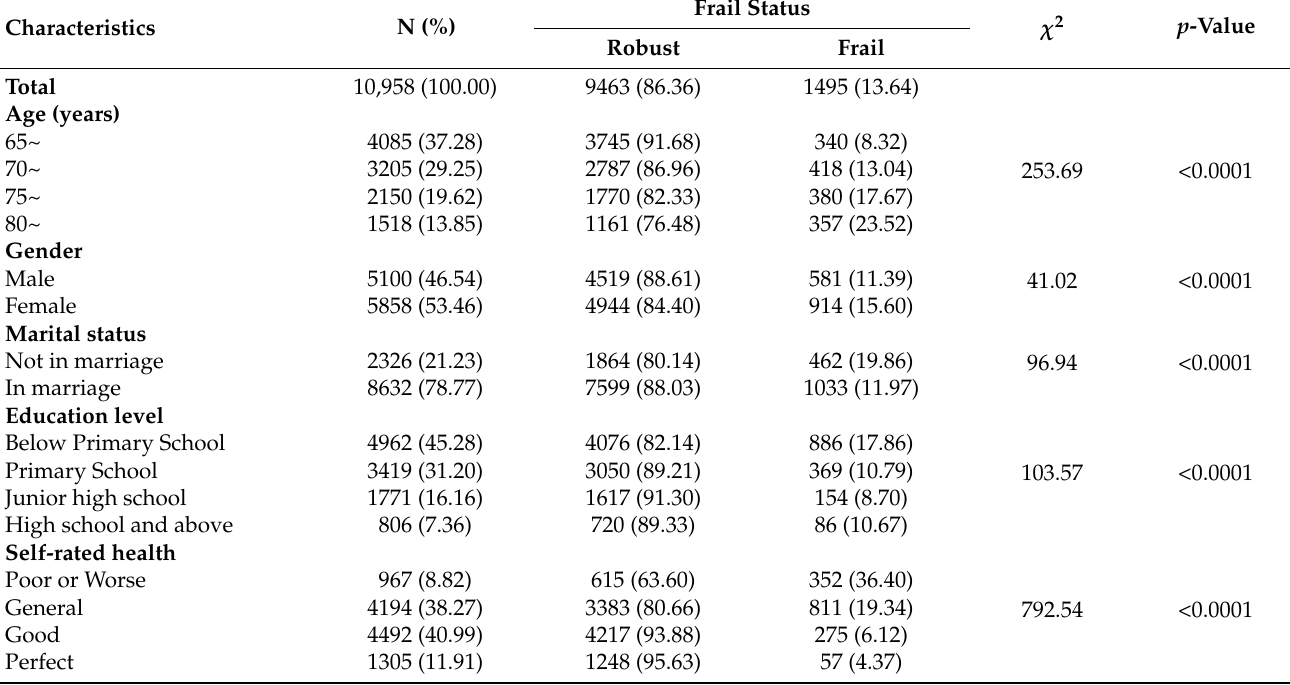
Table 1. Demographic characteristics and frail status of the study